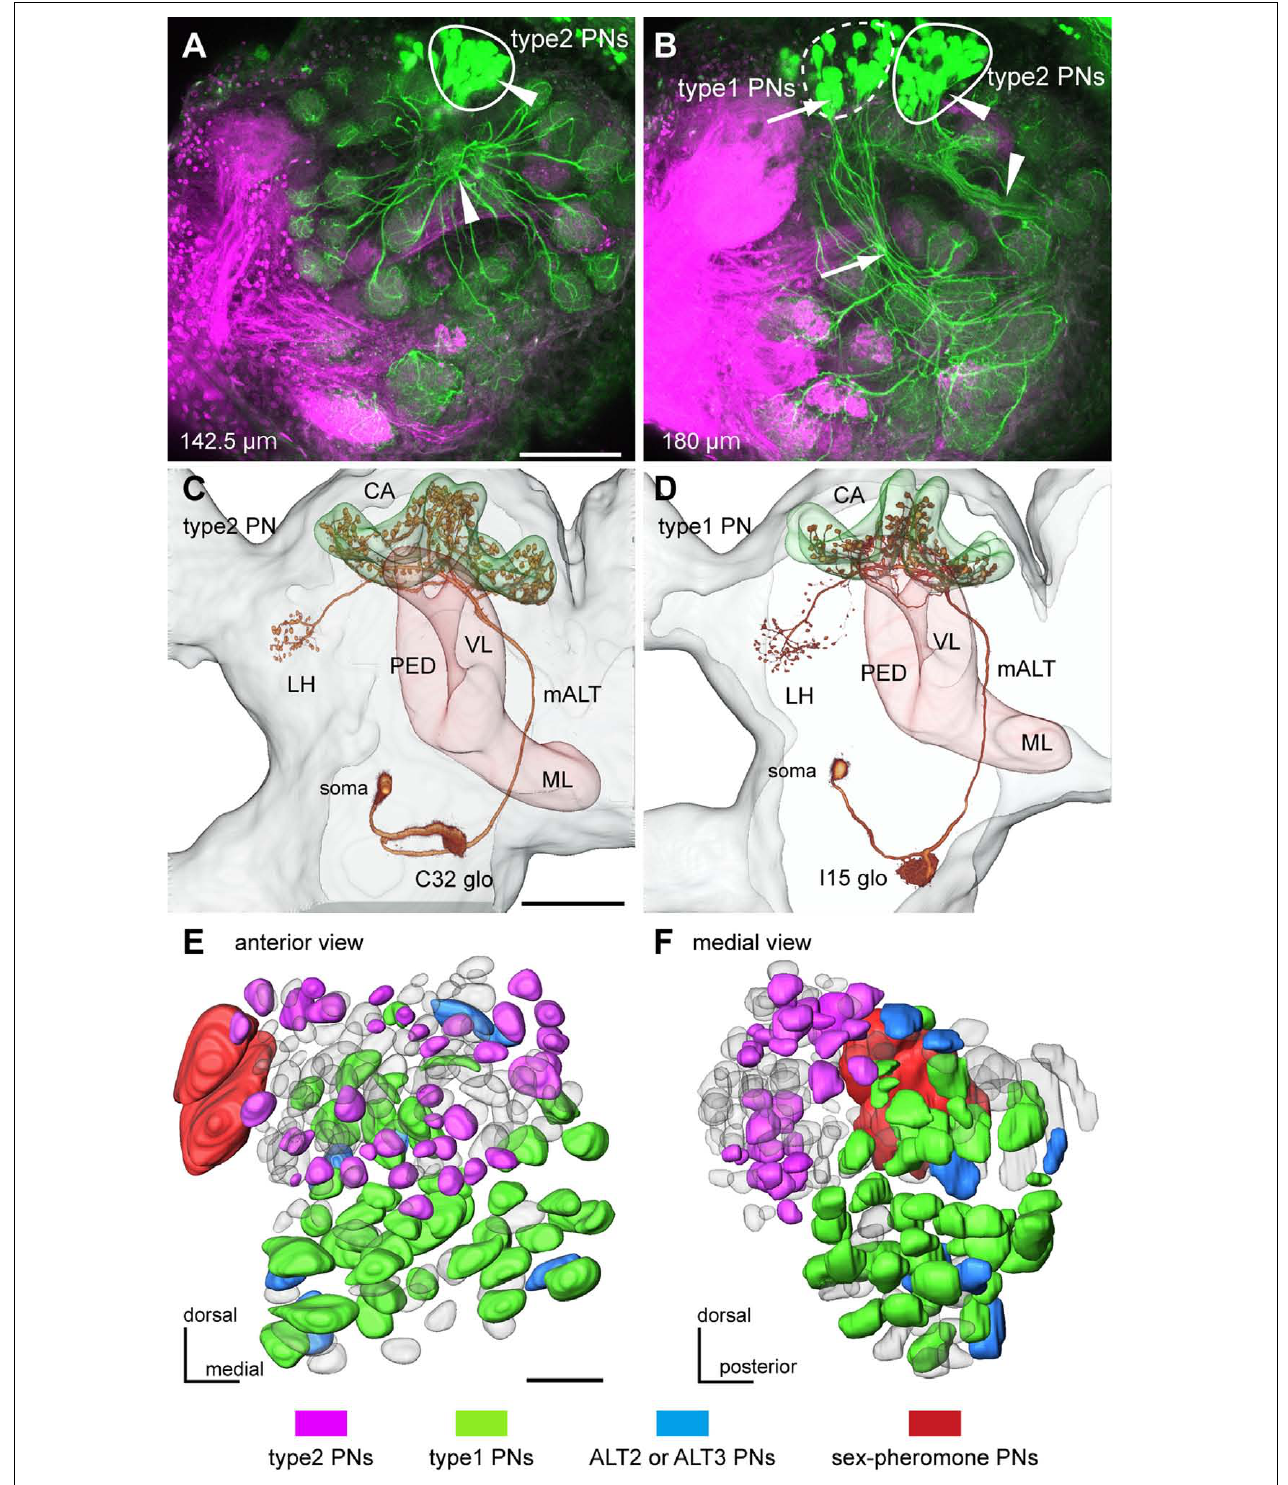
FIGURE 1 | Two major types of uniglomerular projection neurons (PNs) in the cockroach brain. (A,B) Mass staining of PNs in the antennal lobe (AL). PNs (green) were stained by dye injection into the medial ALT (m-ALT) and olfactory sensory neurons (OSNs) (magenta) were labeled by anterograde staining from the antennal nerves. Axons of PNs form two different bundles in the AL (arrowheads and arrows in A,B ), and their cell bodies separately cluster in the dorsal region of the AL. Loci of clusters of cell bodies correspond to the two major types of PNs; type1 and type2 PNs. Depth of serial optical image from anterior surface